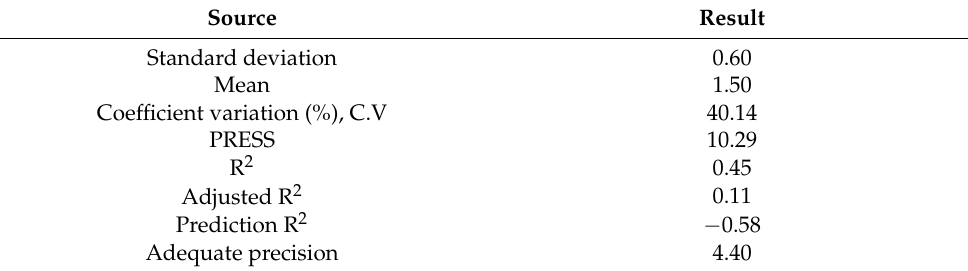
Table 6. Model reliability analysis of adsorption capacity response.